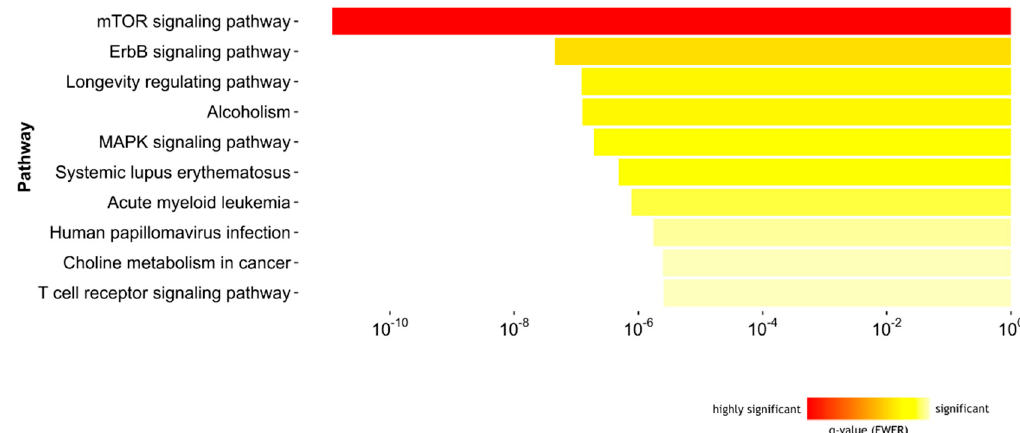
Figure 5. The relationship between DNA methylation changes with biological pathways. The top 10 enriched pathways for the genes within maternal DMRs associated with airborne allergen sensitization at age 5Y in ALADDIN.